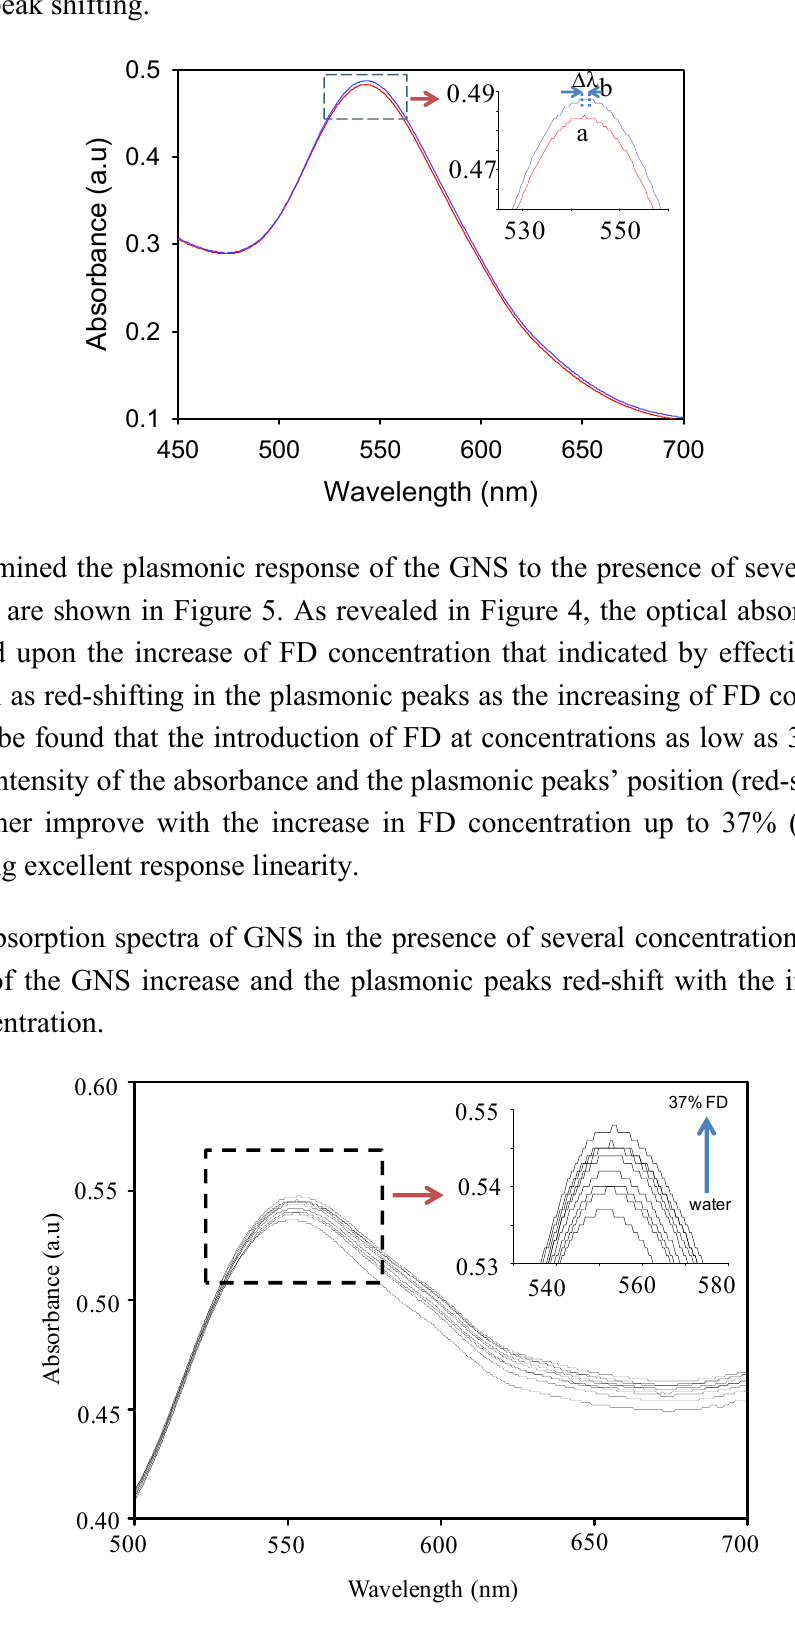
Figure 4. Optical absortion spectra of GNS in water (a) and in the presence of 10% formaldehyde (b). Inset graph indicates the change in the spectra involves absorbance change and peak shifting.